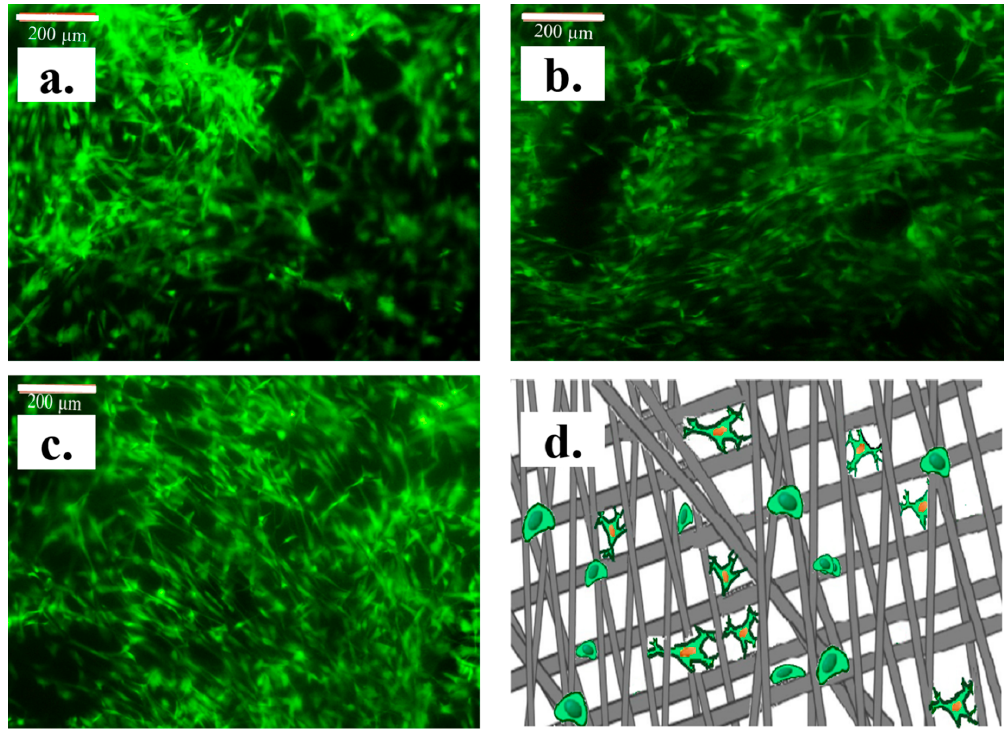
Figure 8. Cells cultured on nanofibrous mats of ( a ) C, ( b ) C-PET and ( c ) PET. ( d ) Schematic mechanism of proliferated cell growth.